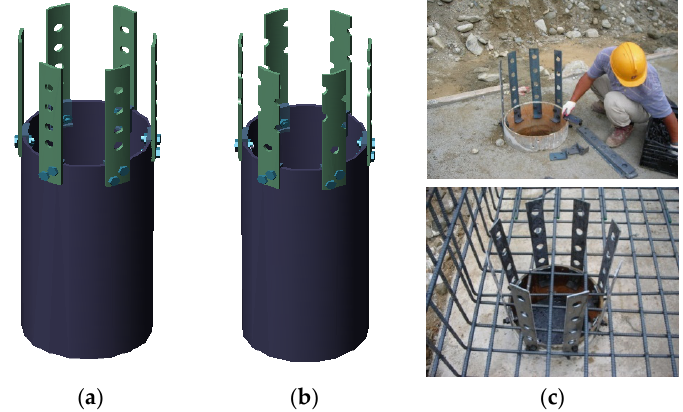
Figure 1. Perfobond shear connector for steel pile cap strengthening. ( a ) Perfobond shear connector with closed holes. ( b ) Perfobond shear connector with open holes. ( c ) Connection between the steel pile and perfobond shear connectors.